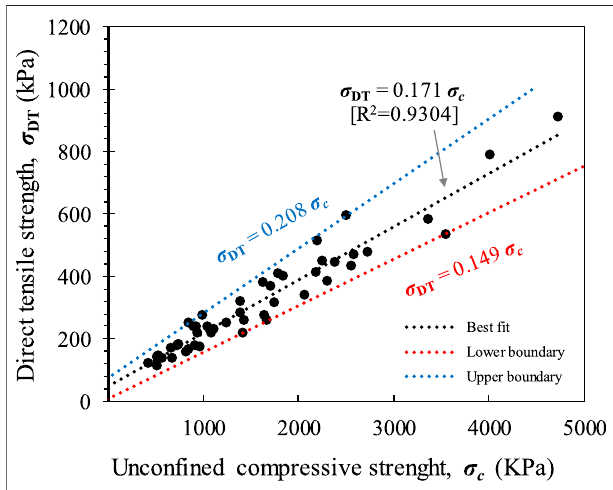
FIGURE 8 | Variations of direct tensile strength σ DT against uncon fi ned compressive strength σ c for all CPB mix designs.